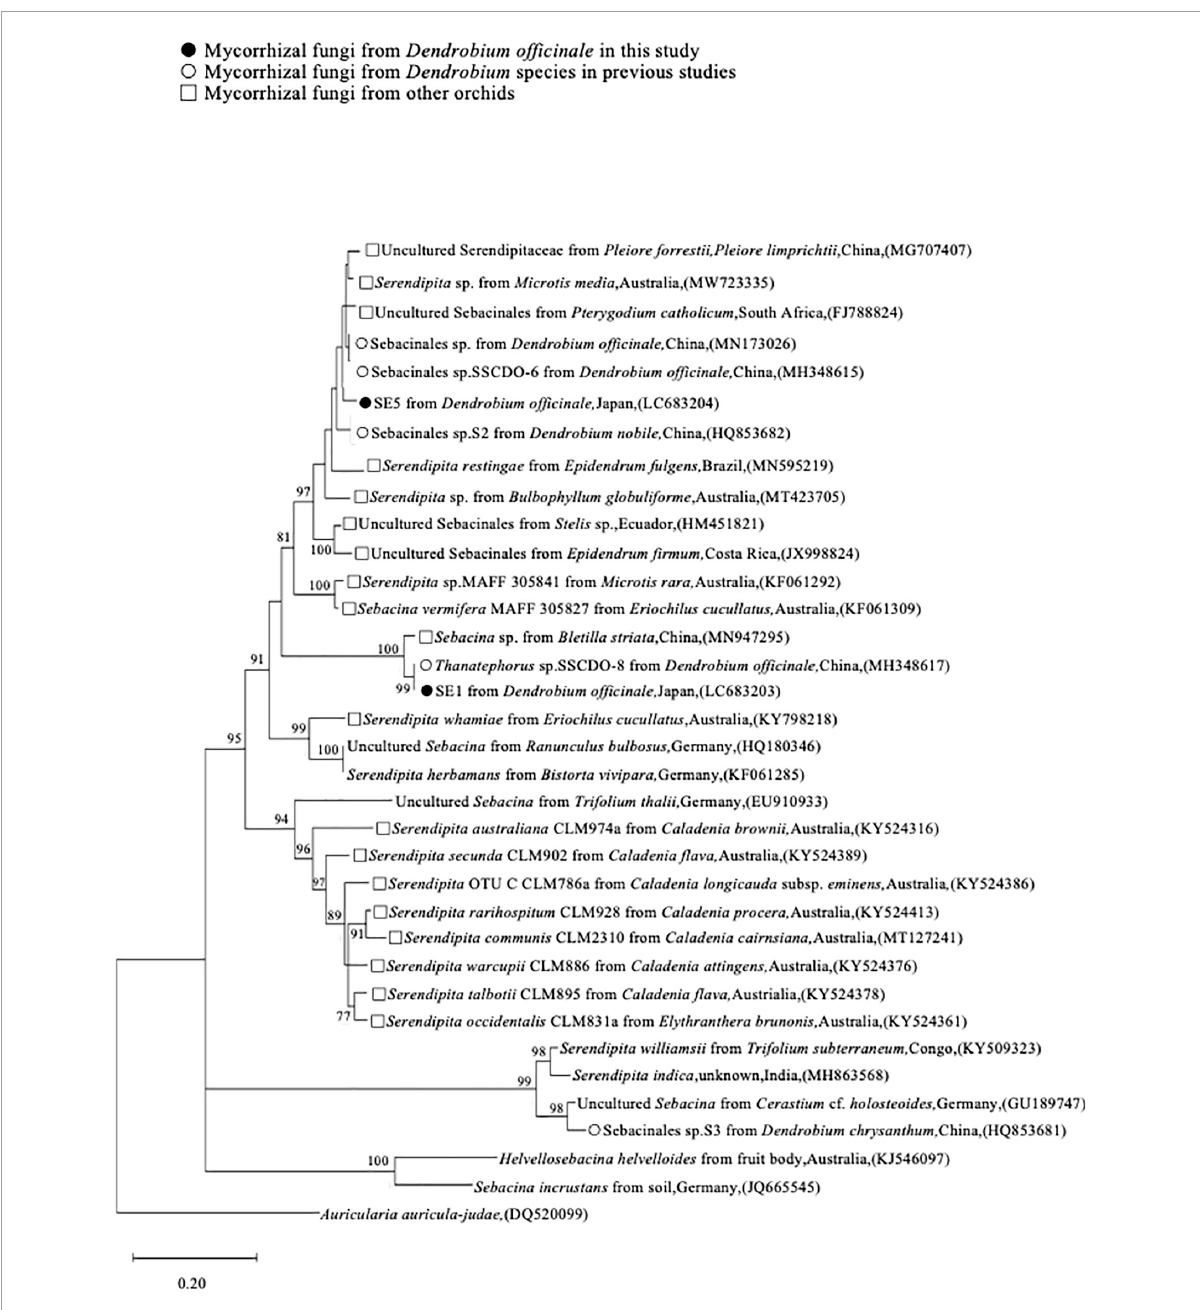
FIGURE4 Maximum likelihood tree for Serendipitaceae internal transcribed spacer (ITS) sequences, including those of two OTUs from this study. Symbols indicate the origin of each sequence. Only bootstrap values ≥ 70% are shown. The tree is drawn to scale, with branch lengths reflecting the number of substitutions per site. Auricularia auricula-judae was used as an outgroup taxon. The 35 assembled sequences were aligned, and the final dataset included 382 bp